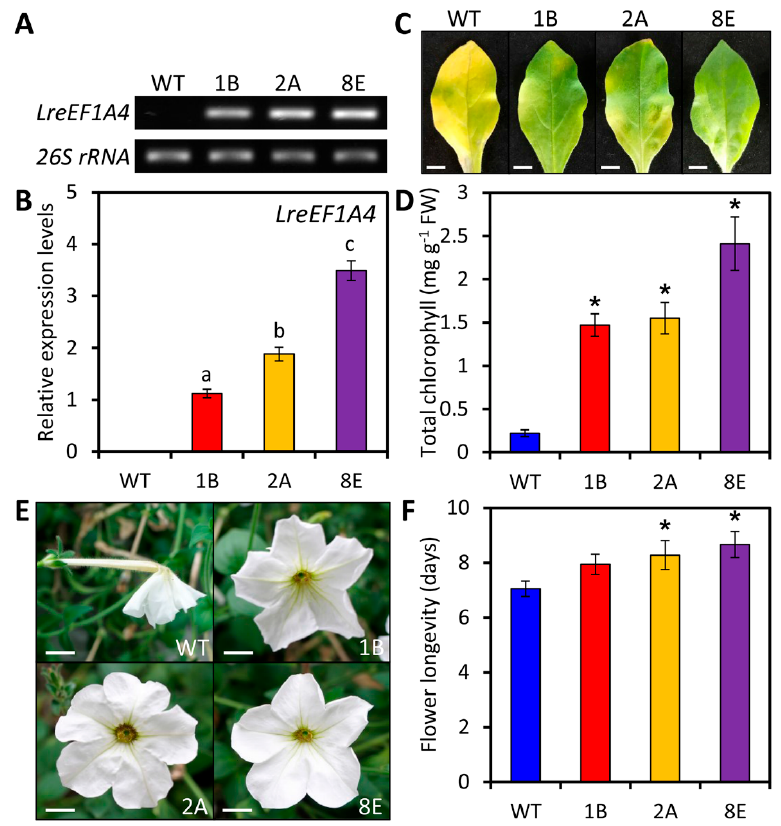
Figure 4. Delayed leaf and flower senescence in transgenic petunia plants overexpressing LreEF1A4 . Semi-quantitative reverse transcription-polymerase chain reaction (RT-PCR) ( A ) and quantitative real-time PCR ( B ) analyses of LreEF1A4 expression levels in the leaves of wild-type (WT) and LreEF1A4 -overexpressing transgenic petunia lines (1B, 2A, and 8E). 26S rRNA was used as a reference gene. Representative phenotypes ( C ) and total chlorophyll content ( D ) of the leaves at the bottom of 8-week-old WT and transgenic lines. Scale bars = 1.0 cm. Representative phenotypes of attached unpollinated flowers at 8 days after anthesis ( E ) and longevity of flowers ( F ) from WT and transgenic petunia plants. Scale bars = 1.0 cm. Error bars represent standard error (SE) of the mean from three independent biological replicates. Significance of di ff erence was determined using one-way analysis of variance (ANOVA) test ( p < 0.05) and shown as various letters, or using Student’s t -test ( p < 0.05) and marked by